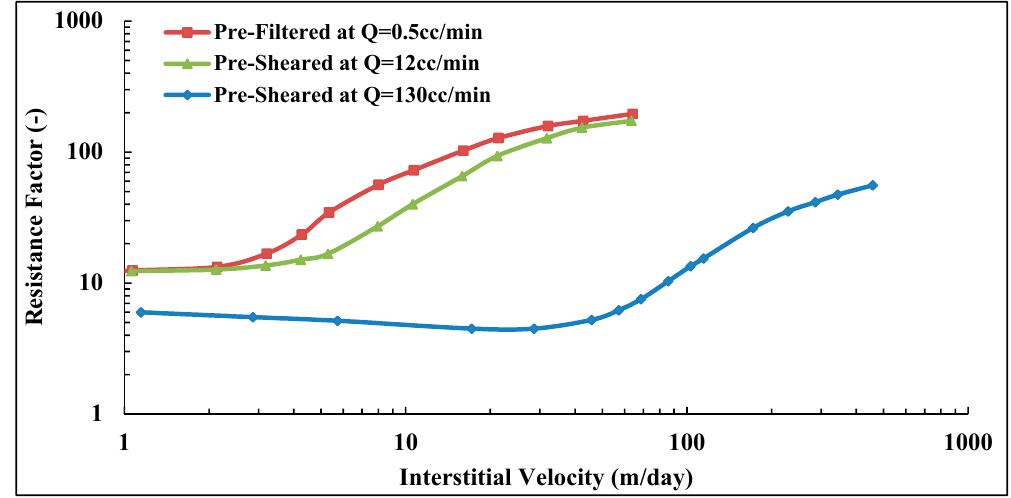
Figure 16. Resistance factor of pre-sheared Solution A at different flow rates verses prefiltered solution. Table 7. Core and solution properties for pre-sheared Solution A and B at very high flow rates. Exp.